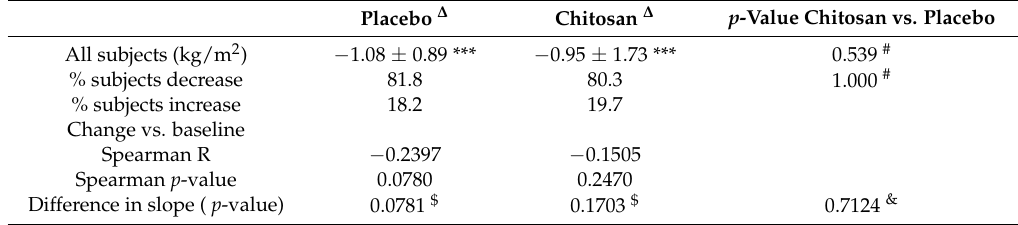
Table 3. Comparison of changes in BMI resulting from chitosan and placebo treatments.